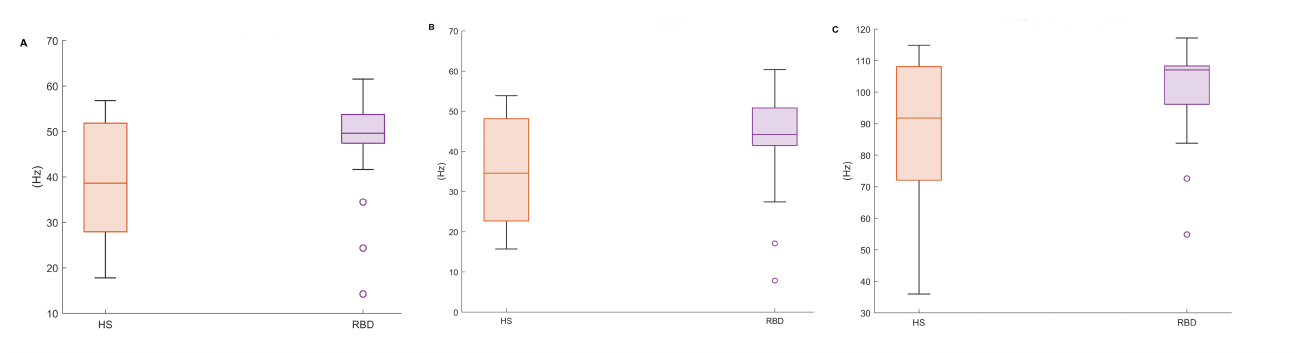
Figure 6. Boxplots of the proposed EMG spectral features, in both healthy (HS) and RBD subjects (RBD). ( A ) Mean Frequency, ( B ) Median Frequency, ( C ) SEF95. CAP database.